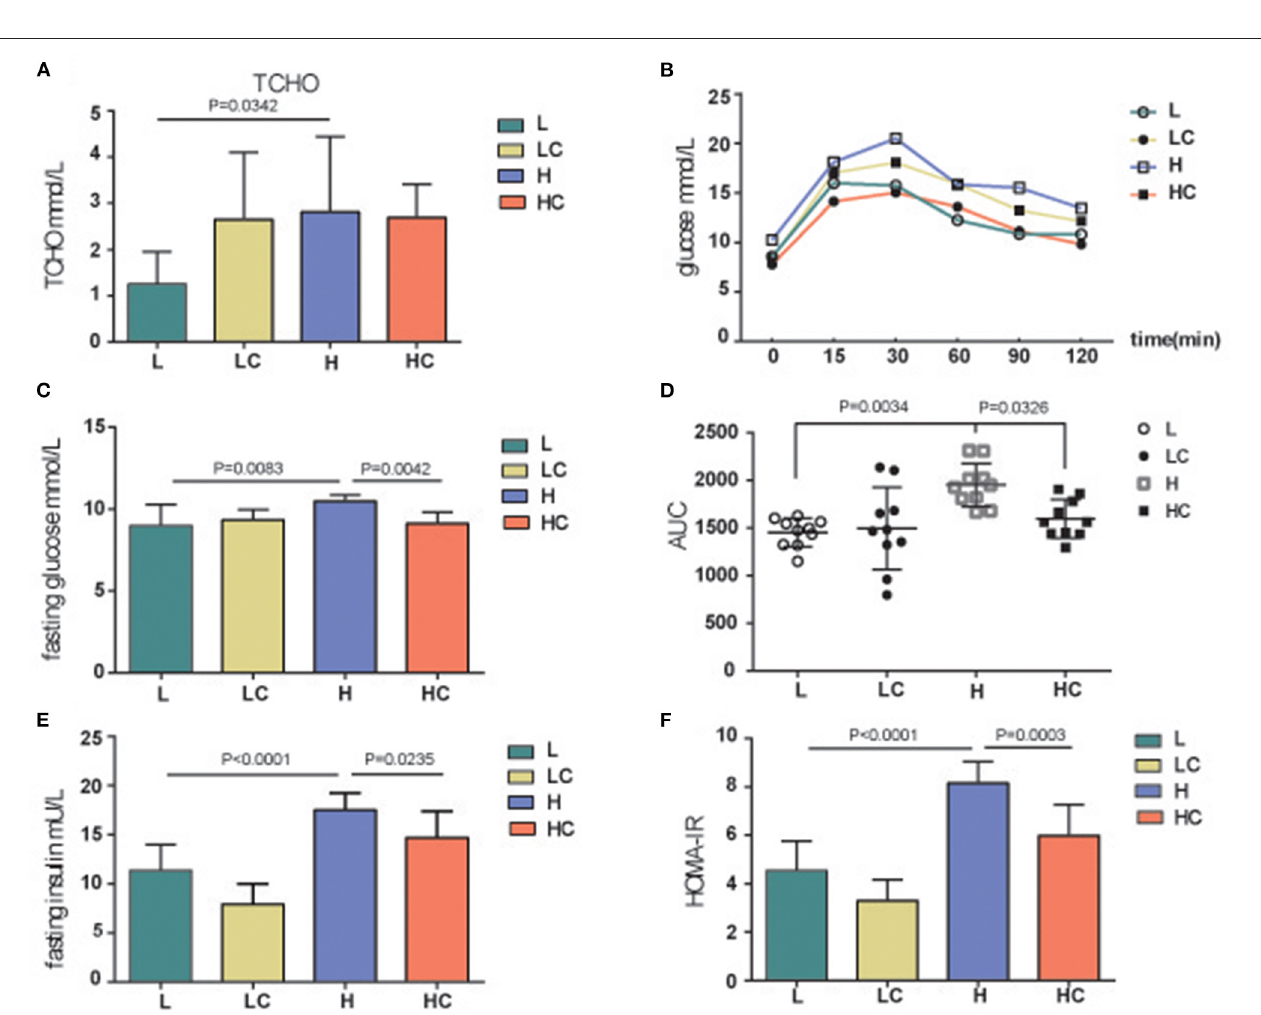
FIGURE 2 | Blood glucose, insulin and physiological metabolites analysis. TCHO (A) , Glucose (B) , Fasting glucose (C,D) , Fasting insulin (E) and insulin resistance ( F , HOMA-IR) levels of different groups. Groups: Group L (low-fat diet group, fed with 4.3% fat, 5% cellulose); LC group (low-fat diet + COS group, fed with 4.3% fat, 5% COS); group H (high-fat diet group, fed with 35.4% fat, 5% cellulose); and HC group (high Fat diet + COS group, fed with 35.4% fat, 5%